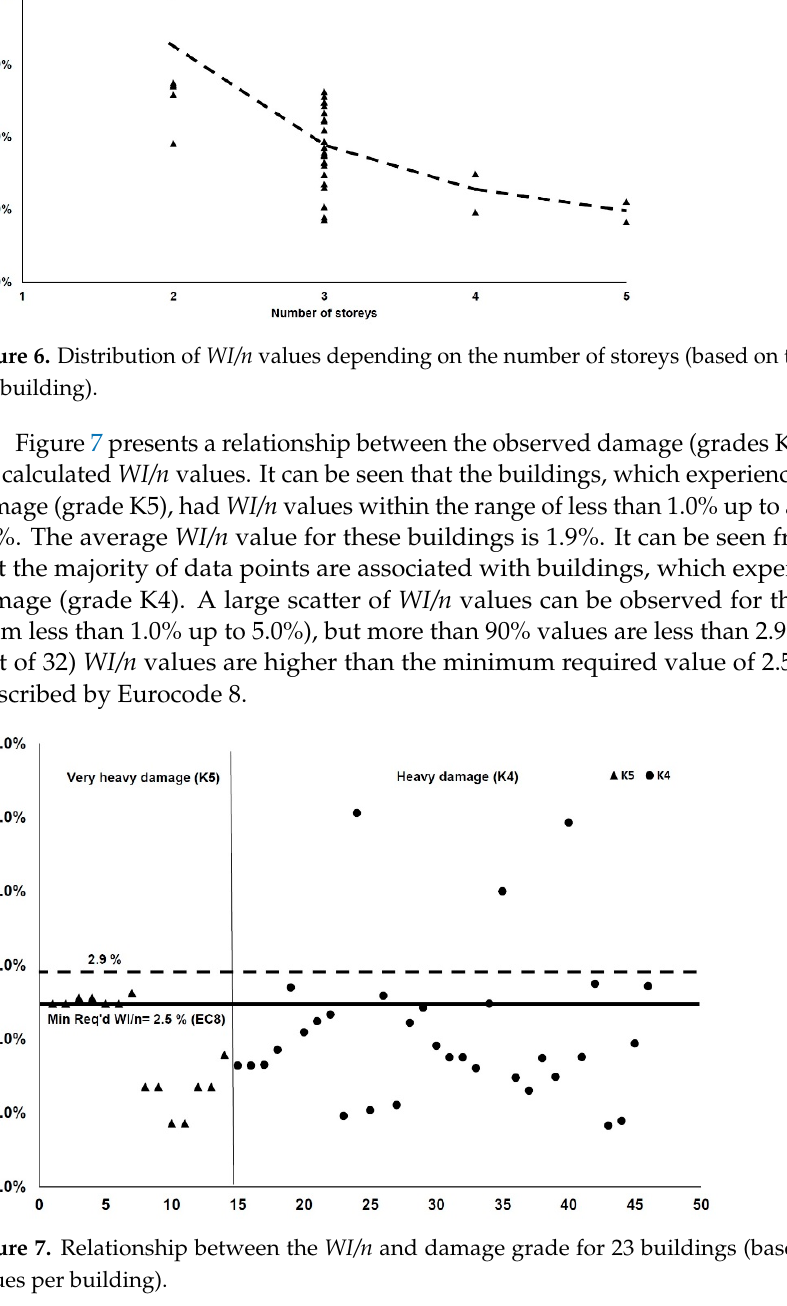
Figure 5. Histogram of WI/n values for 23 buildings (based on two WI/n values per building).